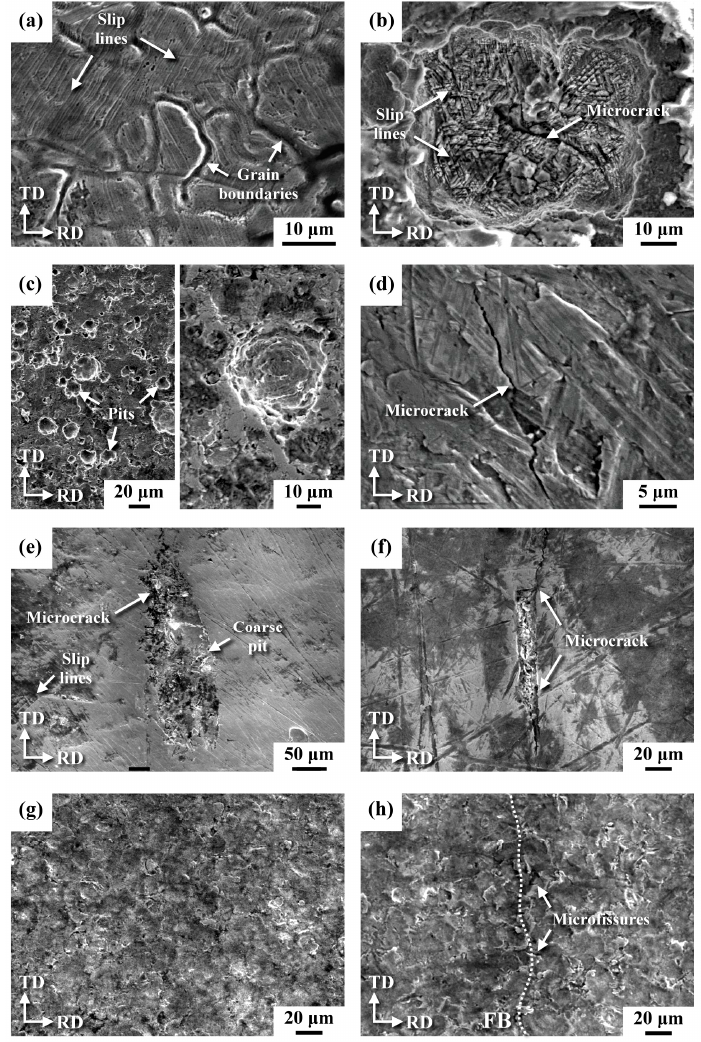
Figure 12. Surface appearance of the U-bend samples after salt spray: ( a ) 304 BM, ( b ) micro-shot peened 304 BM, ( c ) micro-shot peened 304 FZ, ( d ) microcrack in the FZ of the non-peened 304L weld, ( e ) corrosion pit at the FB of the non-peened 316 weld, ( f ) microcrack along the FB of the non-peened 304 weld, ( g ) micro-shot peened 316 BM, ( h ) micro-shot peened 316 around the FB.